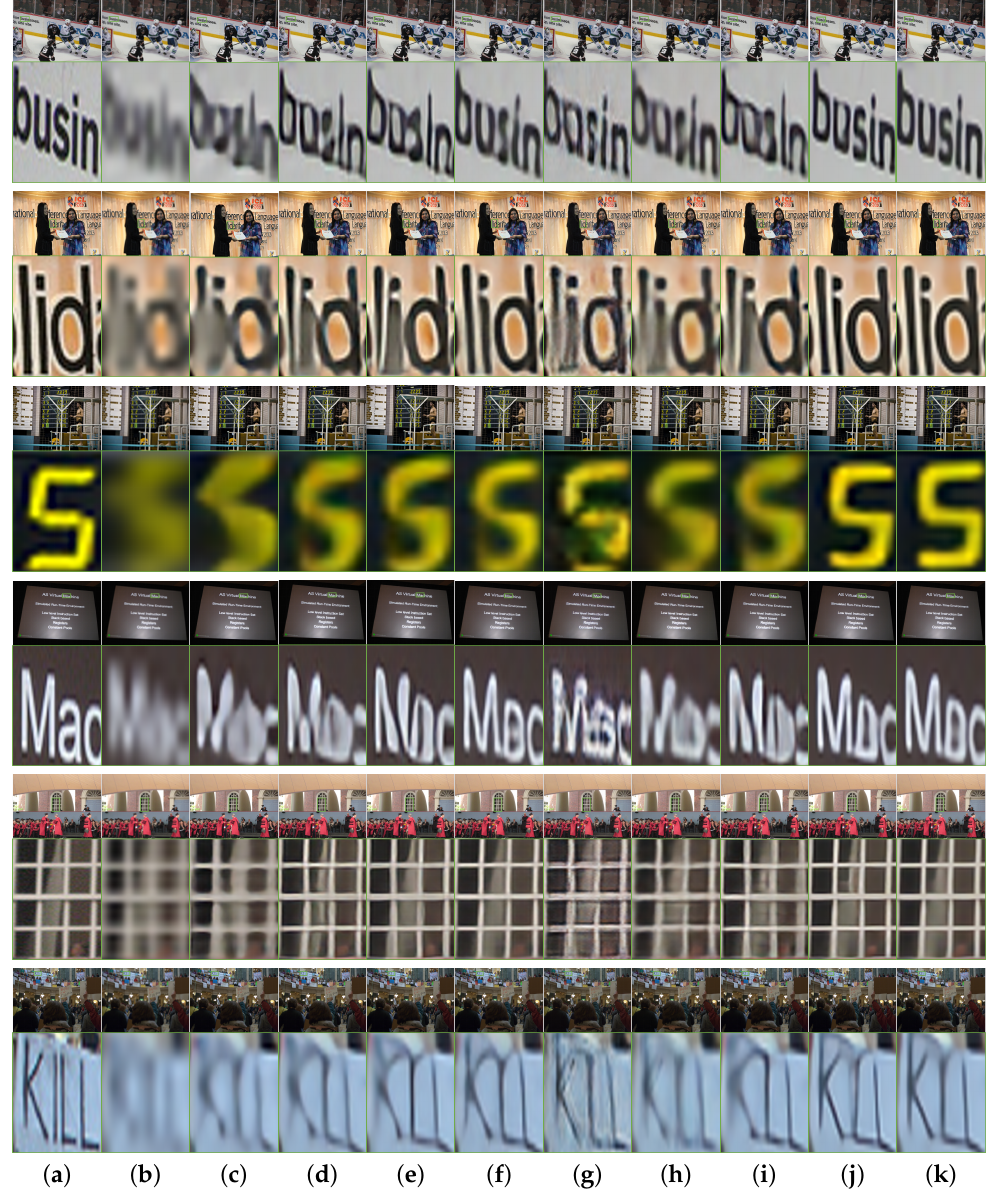
Figure 1. Qualitative comparison of RefSR methods on the CUFED5 datasets. ( a ) GT